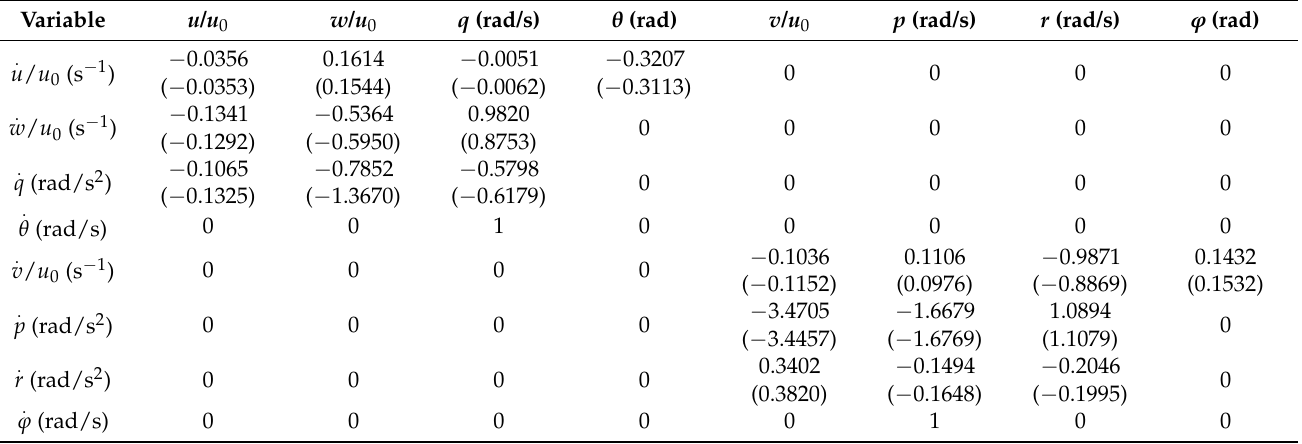
Table 22. CFD–RANS (extrapolated) 8 × 8 stability matrix for flight condition 16 in Tables 4 and 22 (reference takeoff